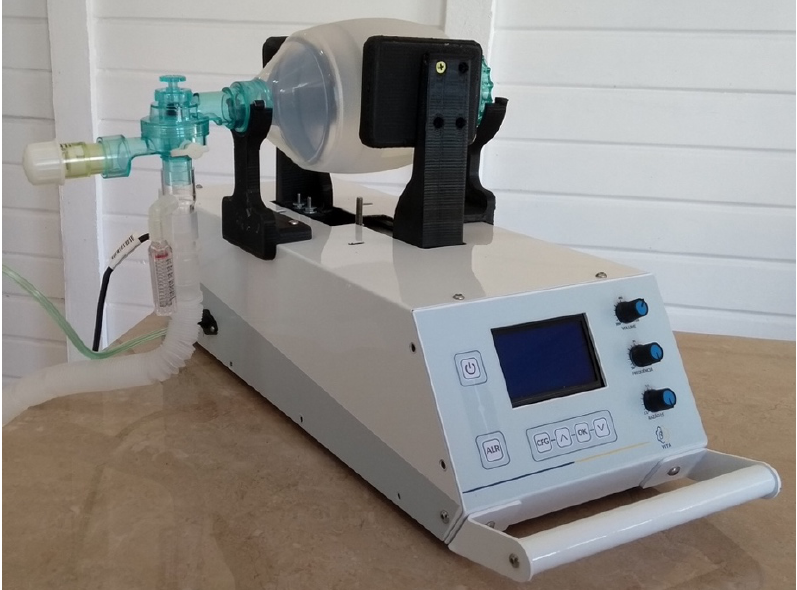
Fig. 4. Vita Pneuma, developed and adapted by INESC P&D Brasil from the original Pneuma